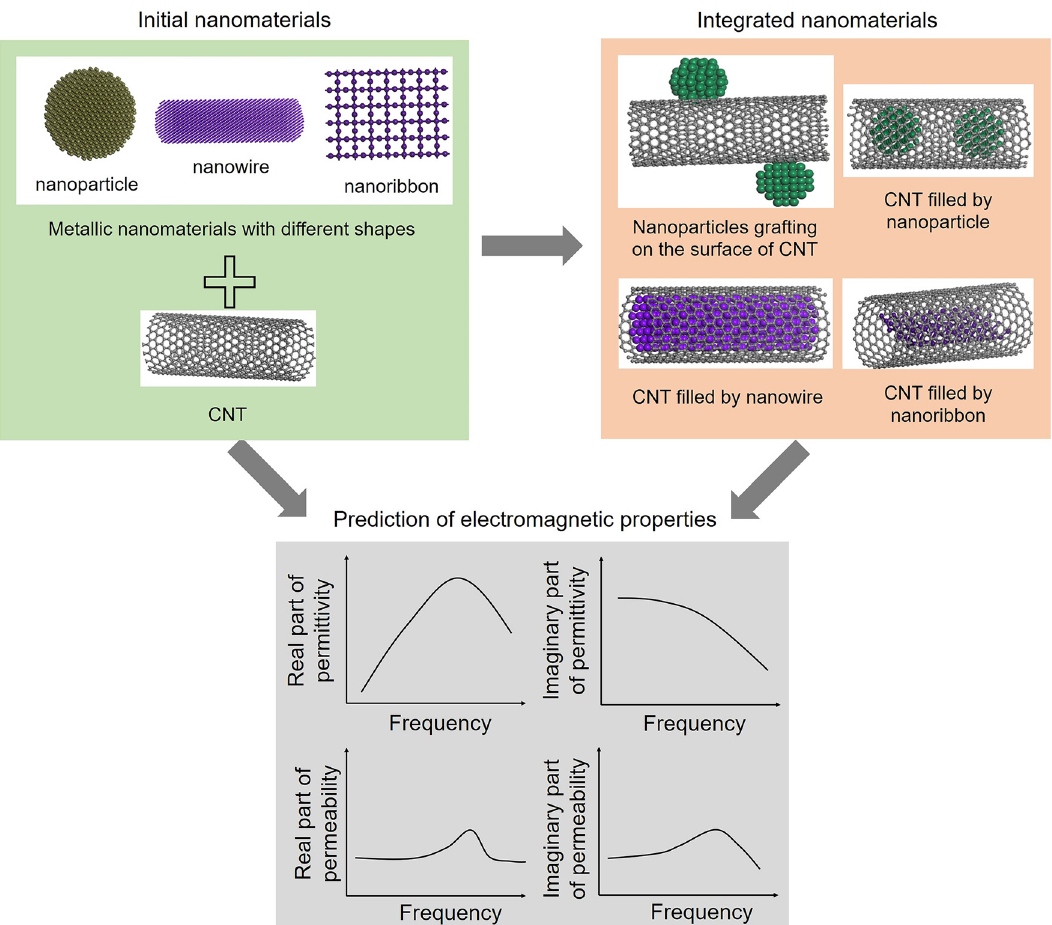
Figure 5: The role of MD simulations in systemization and optimization of nanomaterials. The relationship between the nanostructure and the properties of nanomaterials for nanoantennas can be fi gured out by MD simulations. The properties of integrated nanomaterials are optimized to meet the requirement of